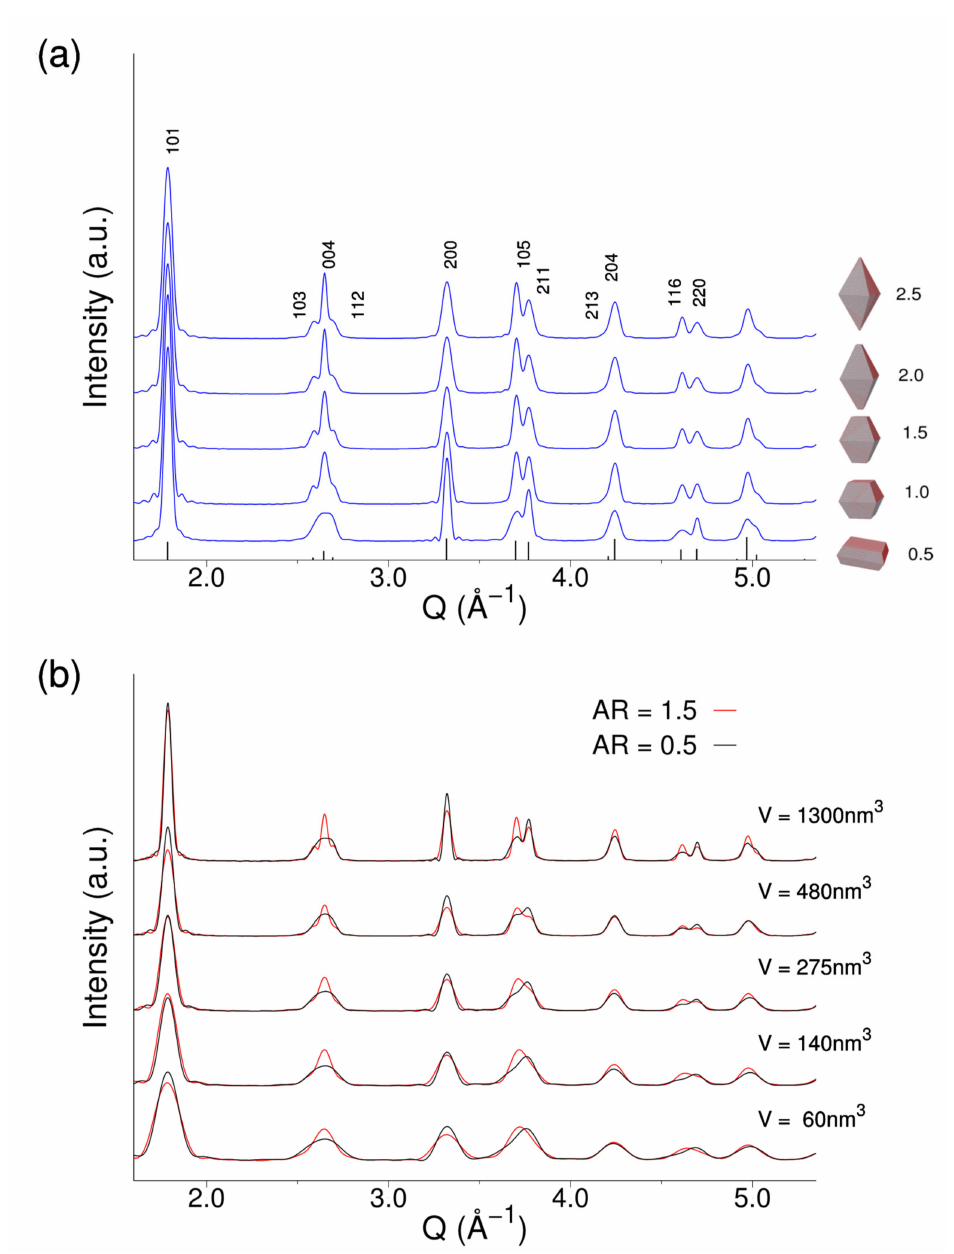
Figure 2. Simulated X-ray scattering patterns for anatase nanocrystals (NCs) having truncated bipyramidal shapes, ( a ) with di ff erent aspect ratios, AR , at constant volume (1300 nm 3 ) and ( b ) with di ff erent volumes at constant AR = 0.5 and AR = 1.5. Simulations in ( a ) are on the absolute scale, whereas in ( b ) scaling was applied to facilitate the comparison of nanocrystals with di ff erent